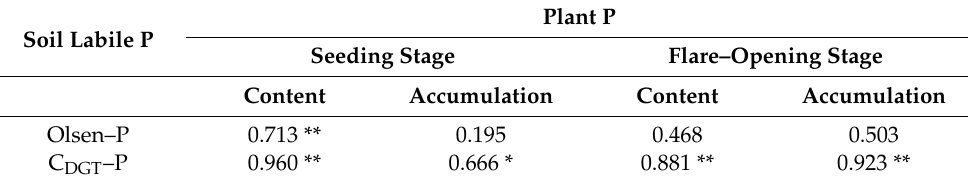
Figure 3. Effects of fertilizer application on Olsen–P ( a ) and C DGT –P ( b ) at the seeding stage and flare–opening stage in the fifth maize season. The different lowercase letters above the bars at the same stage indicate p < 0.05. Table 3. Relationship between maize plant P and soil labile P using Pearson’s correlation analysis in fertilized soils. Plant P Soil Labile P Seeding Stage